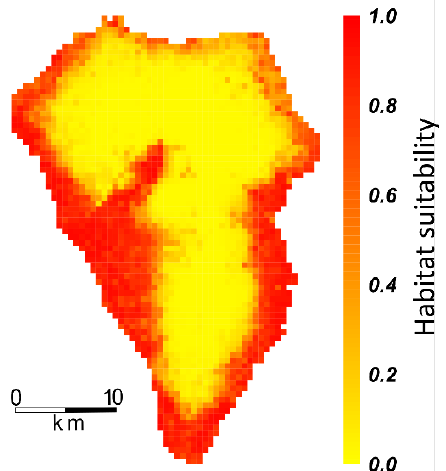
Figure 3. Projected suitable habitat conditions of P. setaceum on La Palma based on the ensemble model of generalized linear model (GLM), gradient boosting machine (GBM), random forest (RF), and maximum entropy model (MaxEnt). Habitat suitability ranges from 1 (high probability of occurrence, red) to 0 (low probability of occurrence, yellow).